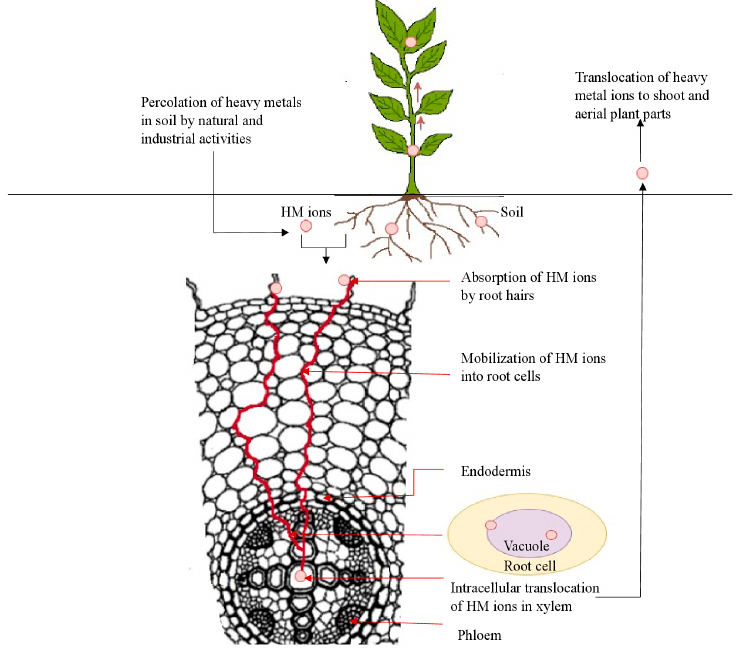
Figure 2. Uptake, translocation and accumulation of heavy metal (HM) in plants.